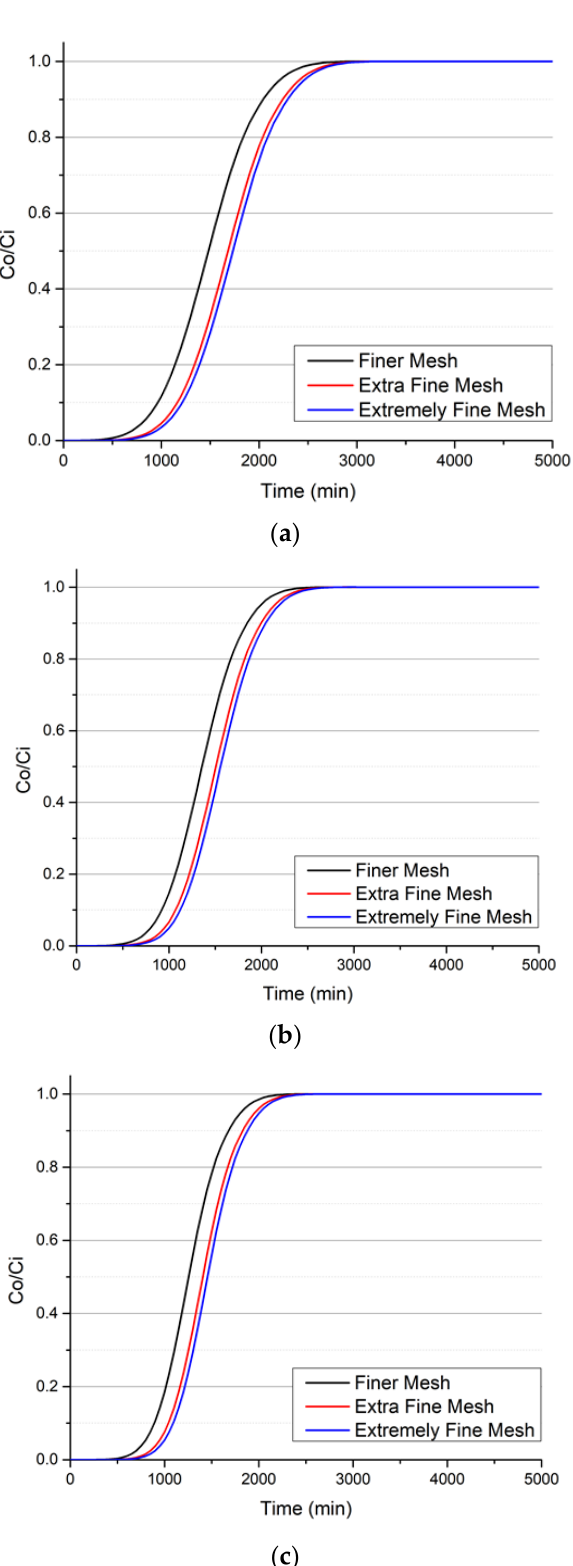
Figure 3. Grid independence test results with simulated cases at a fixed bed depth (40 cm) and a feed flow rate (1 lit/min), but varying feed arsenic concentrations: ( a ) feed concentration of 2.7 mmol/m 3 (a 40 cm bed depth and a 1 lit/min feed flow); ( b ) feed concentration of 4.0 mmol/m 3 (a 40 cm bed depth and a 1 lit/min feed flow); ( c ) feed concentration of 5.3 mmol/m 3 (a 40 cm bed depth and a 1 lit/min feed flow).